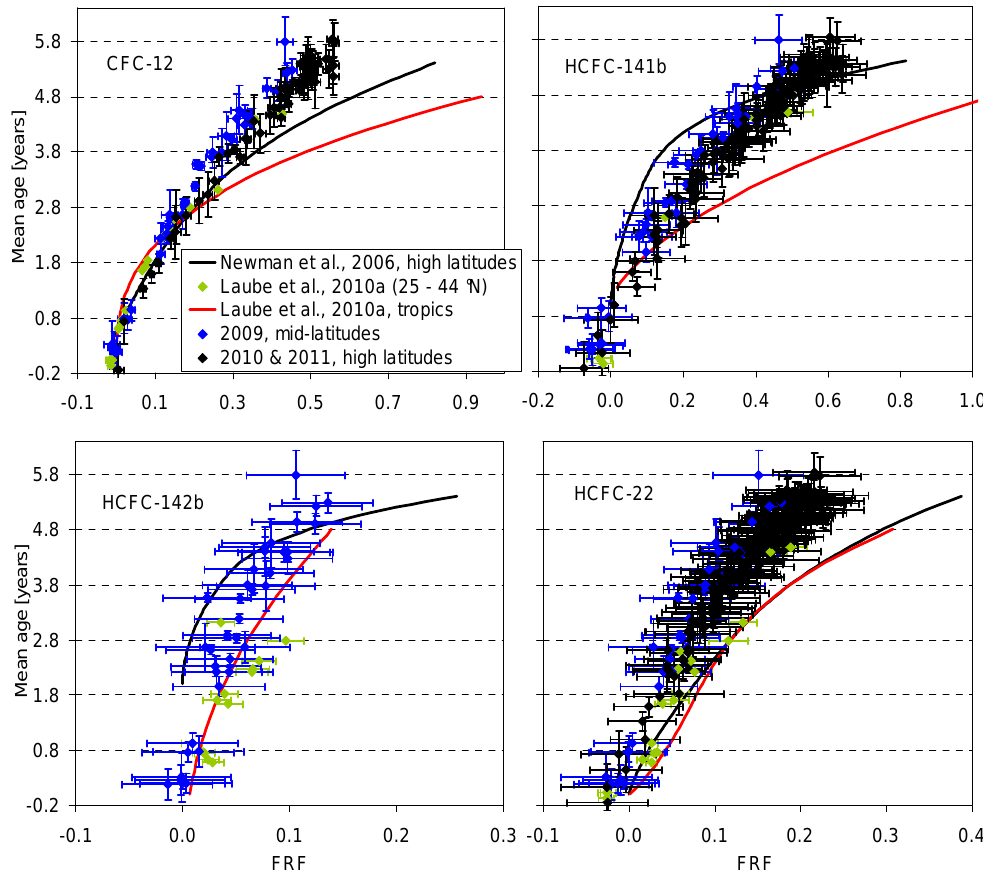
Fig. 4. Same as in Fig. 3 but for CFC-12, HCFC-141b, HCFC-142b and Figure 4. Same as in Figure 3 but for CFC-12, HCFC-141b, HCFC-142b and HCFC-22. 21